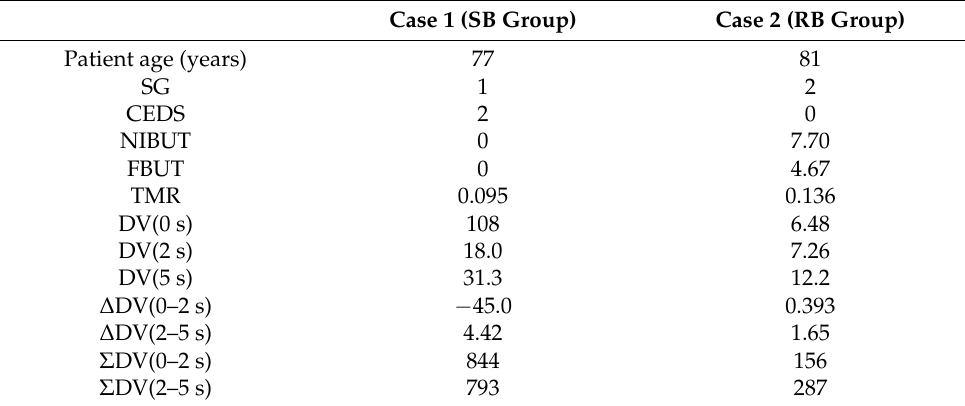
Table 3. OS abnormality and disturbance value related parameters of representative Spot Break Group and Random Break Group cases.